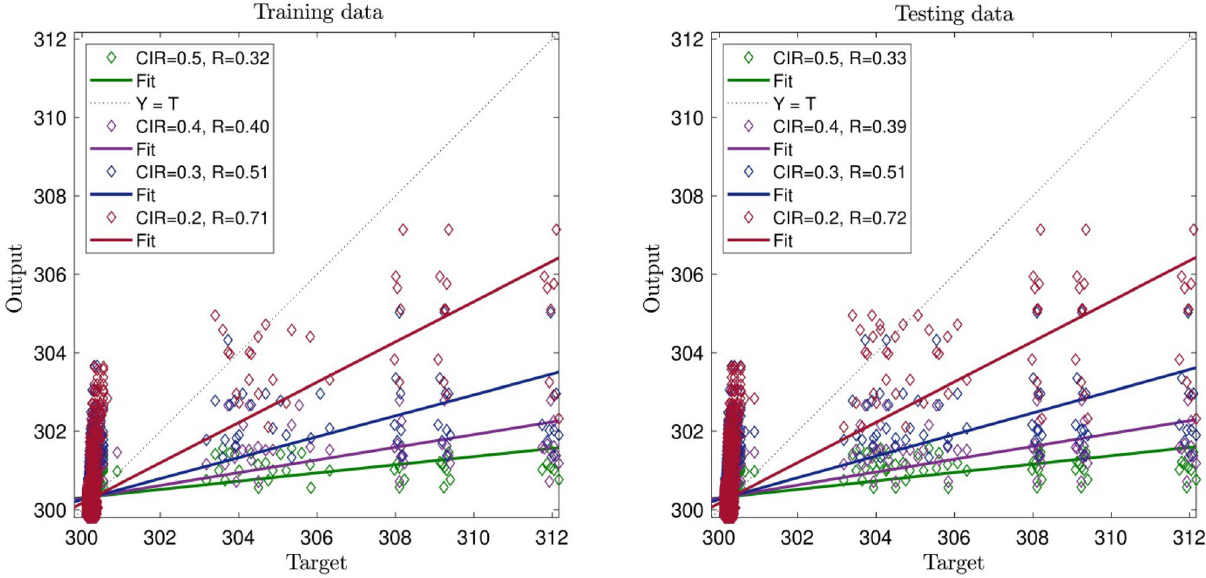
Figure 2. CIR (clustering parameter) changes in the ACOFIS learning processes when the pheromone effect is 0.2 and number of inputs is 2.